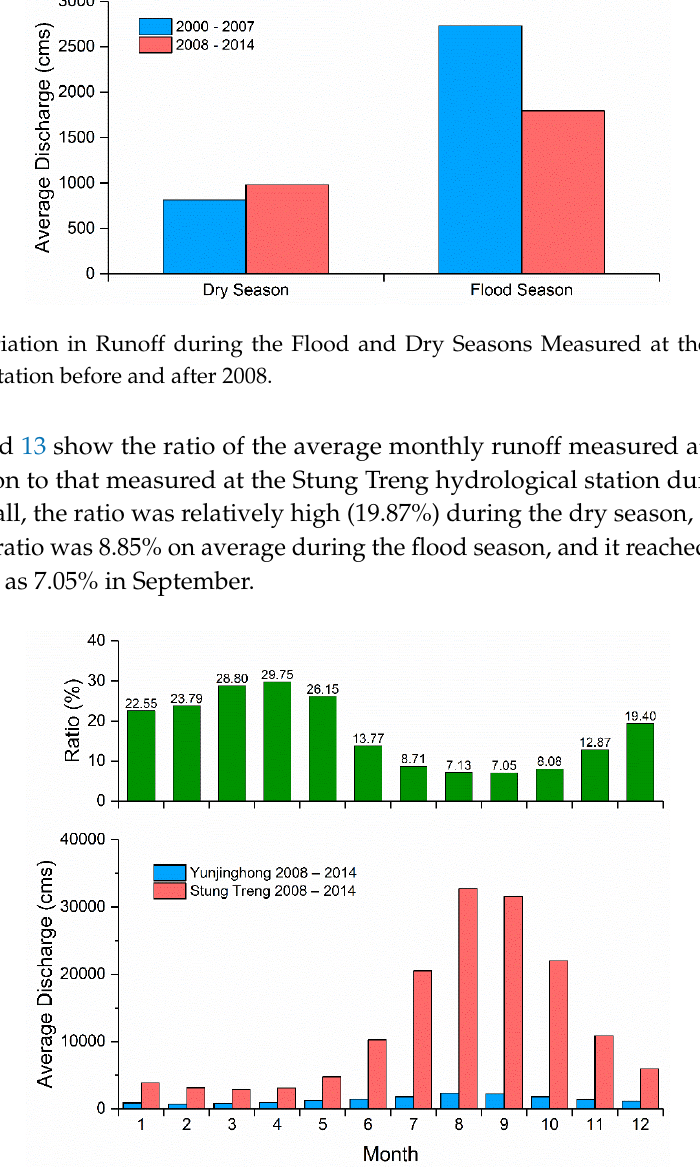
Figure 12. Ratio of Monthly Runoff Measured at the Yunjinghong station to that Measured at the Stung Treng Hydrological Station (Upper Part); Comparison of the Monthly Average Runoff between the Yunjinghong and Stung Treng Hydrological Stations (Lower Part).